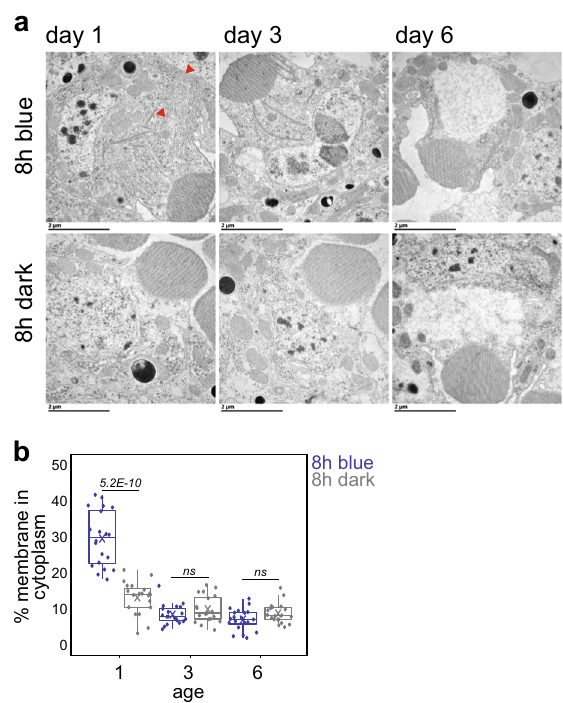
Fig. 3 Blue light induces endoplasmic reticulum expansion in day 1 fl ies. a Transmission electron microscopy of cross sections of ommatidia from adult w 1118 fl ies of the indicated ages exposed to 8 h blue light or dark (control). Sections containing nuclei for a single R1 – R6 cell are shown. Red arrowheads indicate expanded intracellular membranes. Scale bars: 2 μ m. b The percentage of cytoplasm containing intracellular membranes was quanti fi ed using multiple electron microscopy images representing multiple omma- tidia (planes) for each eye ( n = 4 light treatments; 5 animals/ treatment; 1 ommatidium/animal). FDR, pairwise Wilcoxon Rank Sum eyes. H 2 O 2 levels increased in the retina of day 6 fl ies following blue light treatment, indicating that blue light exposure results in ROS generation (Fig. 6a). The blue light-induced increase in H 2 O 2 levels was not observed in day 1 fl ies, which also showed lower basal (dark) levels of H 2 O 2 as compared with day 6 fl ies (Fig. 6a). Overexpression of Cyt-b5-reduced H 2 O 2 levels in the retina of both dark and blue-exposed day 6 fl ies relative to the Luciferase control (Fig. 6a). Thus, blue light increases ROS levels in the eye, which are suppressed by overexpression of Cyt-b5.